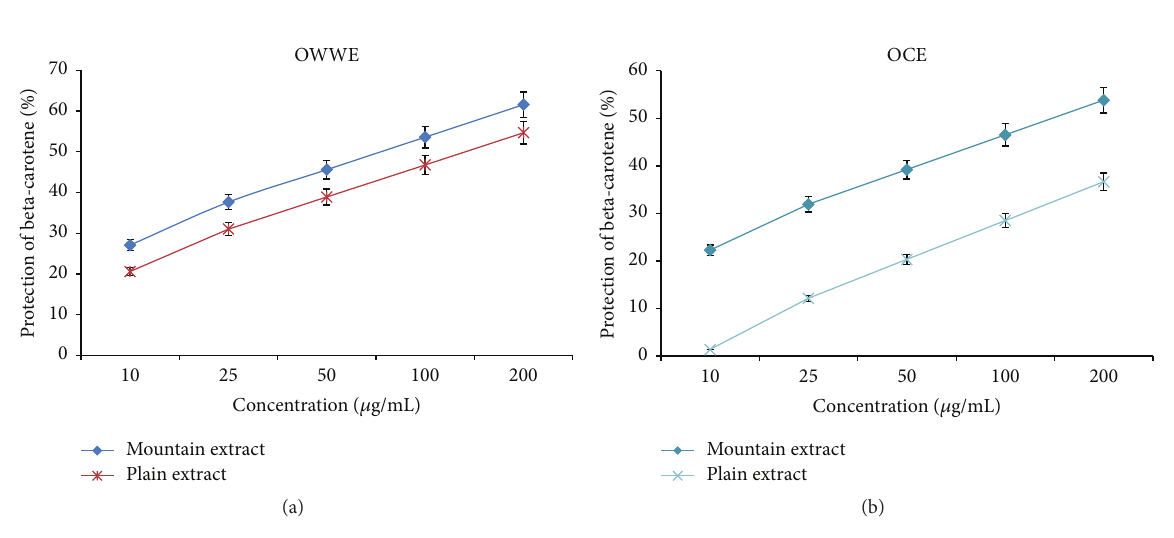
Figure 4: Dose-response curve of antioxidant activity of OCE and OWWE in